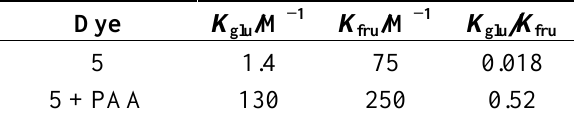
Table 3. The binding constants of dye 5 (20 μM) to sugars in the absence and presence